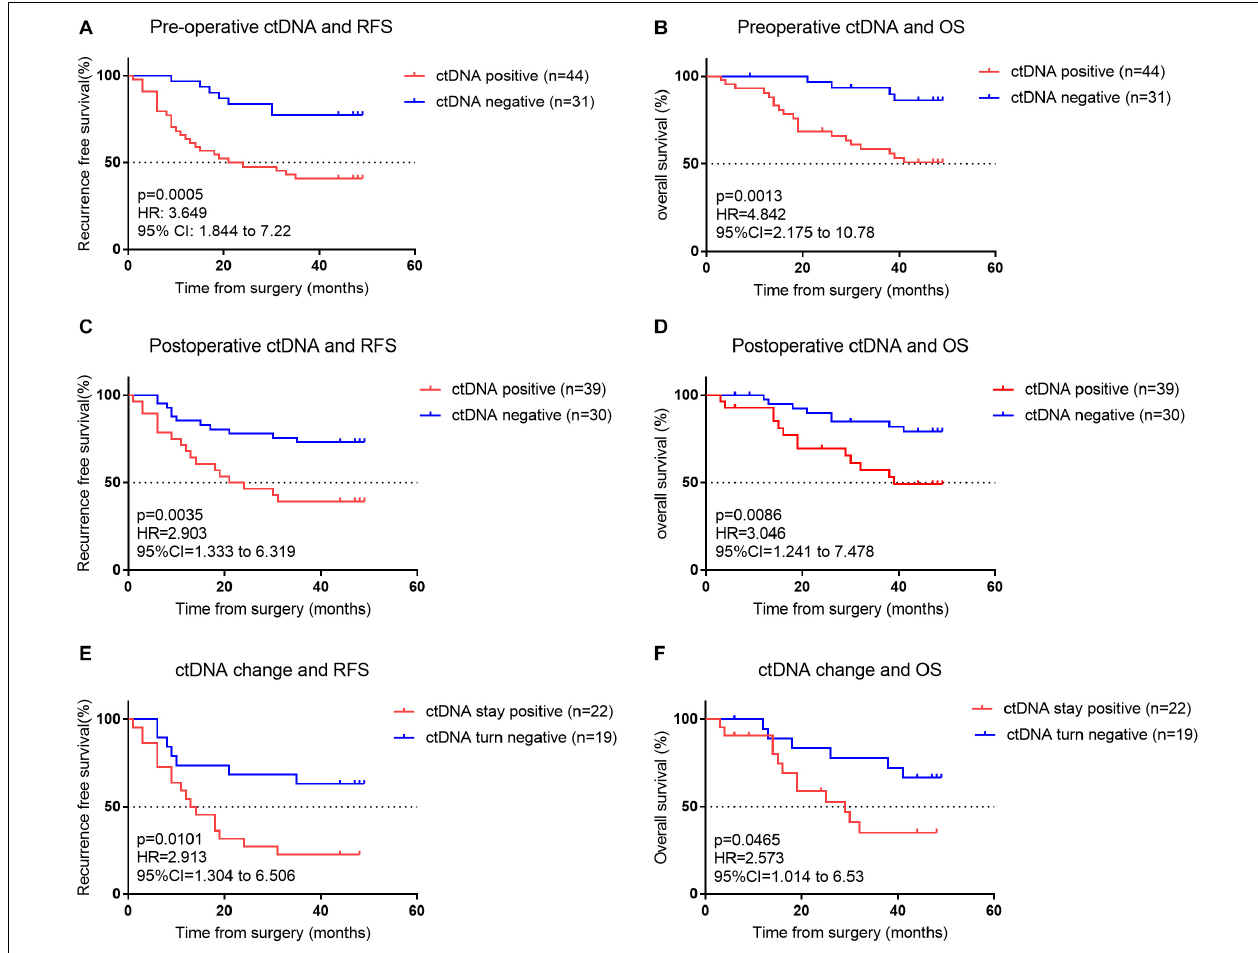
FIGURE 3 | (A) Kaplan–Meier estimates of recurrence-free survival (RFS) for all assessable patients undergoing curative intent surgery for early NSCLC cancer, stratified by pre-operative ctDNA status: detectable (positive) versus undetectable (negative). (B) Kaplan–Meier estimate for overall survival (OS) for matched patients, stratified by pre-operative ctDNA status. (C) Kaplan–Meier estimates for RFS, stratified by postoperative ctDNA status. (D) Kaplan–Meier estimates for OS, stratified by post-operative ctDNA status. (E,F) Kaplan–Meier estimates for RFS (E) and OS (F) for patients’ whose ctDNA status changes from detectable (positive) pre-operatively to undetectable (negative) post-operatively compared with patients whose ctDNA status remains undetectable (negative) both pre- and